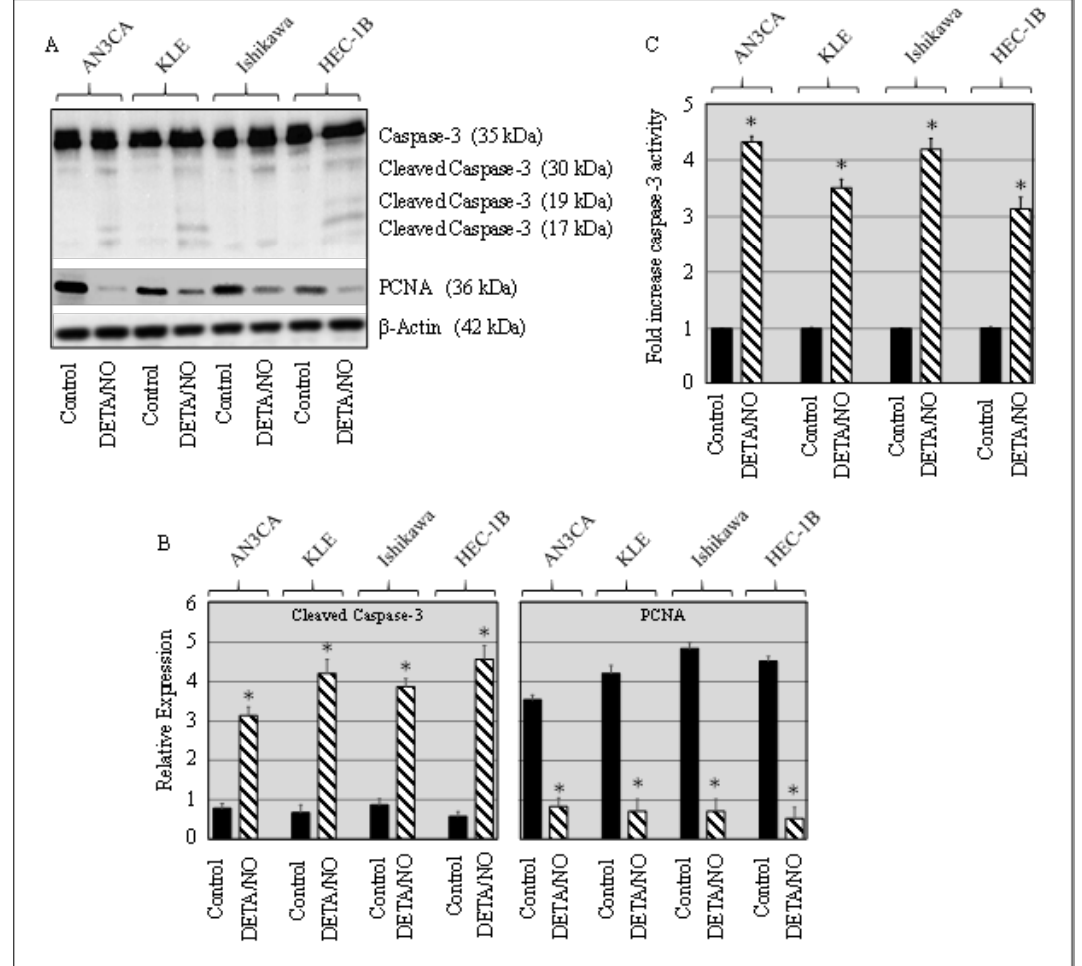
Figure 2. DETA / NO enhanced caspase-3 and attenuated PCNA expression in endometrial Figure 2. DETA/NO enhanced caspase-3 and attenuated PCNA expression in endometrial cancer cells. ( A ) Proteins from vehicle or DETA/NO-treated AN3CA, KLE, Ishikawa, and HEC-1B cells were